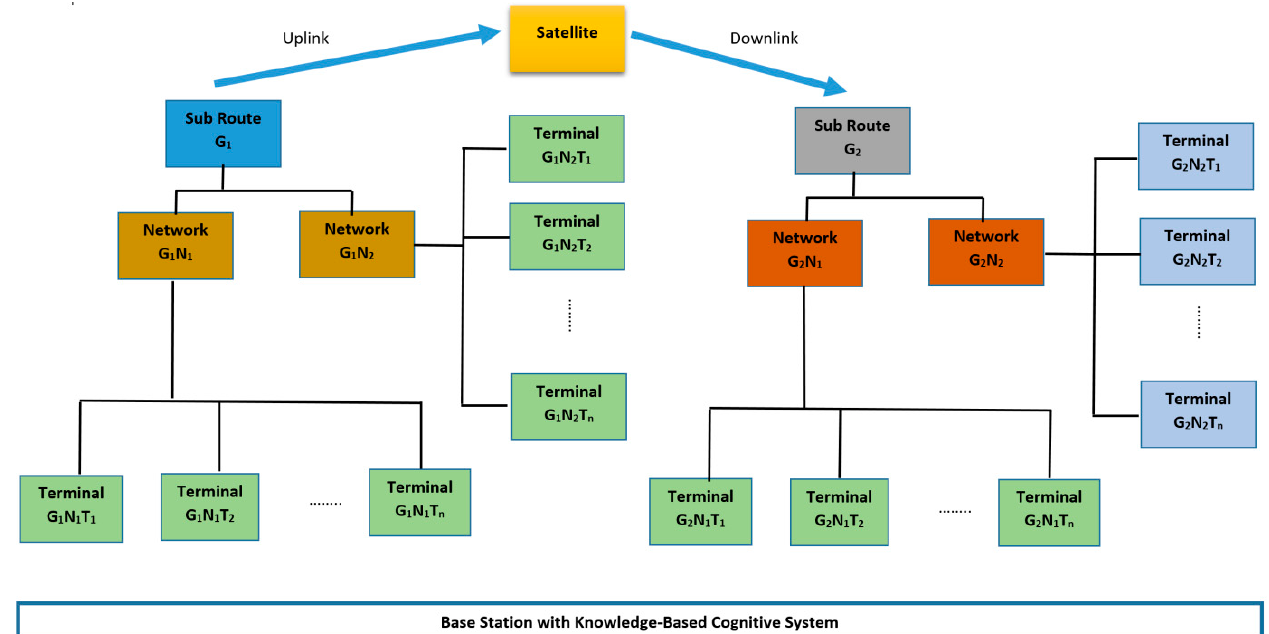
Figure 2. The hierarchical architecture of satellite networks .